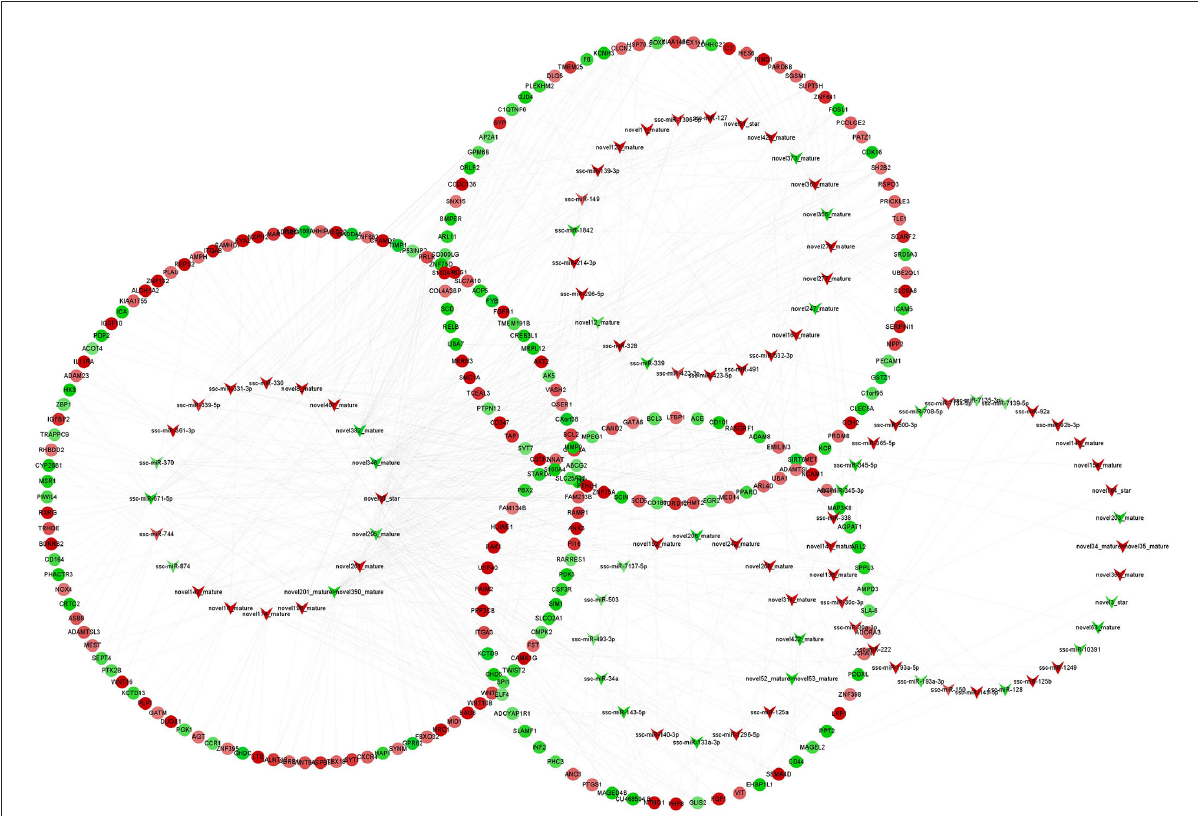
FIGURE4 Regulatory networks of genes. miRNA-mRNA regulatory network in intramuscular and subcutaneous adipose tissue. The circle represents mRNAs, and the arrow represents miRNAs, the red represents up-regulated expression in intramuscular adipose, and the green represents down- regulated